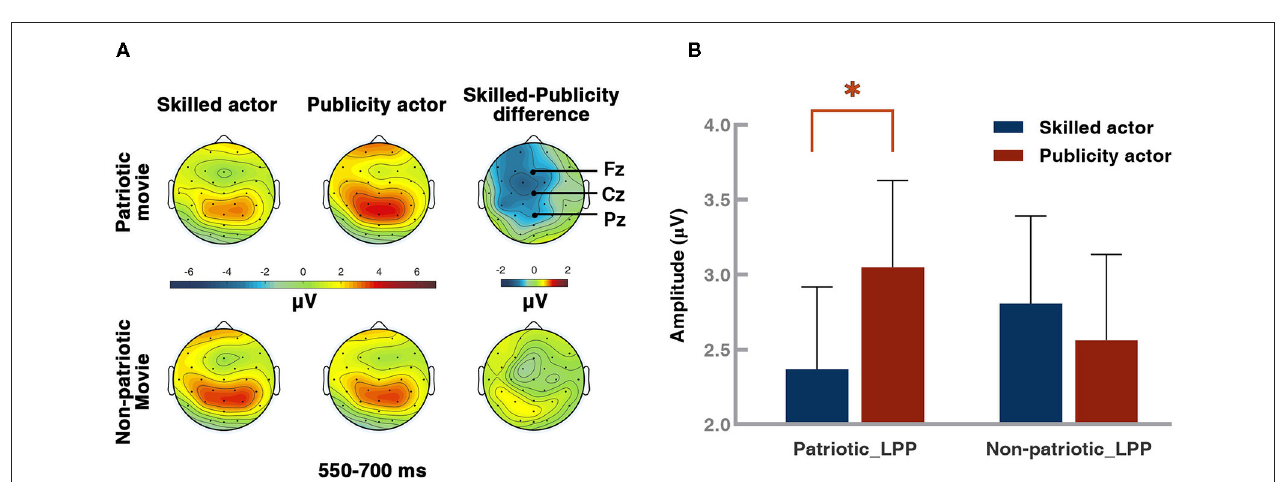
FIGURE 4 | Topography of grand-averaged late positive potential (LPP) waveforms from Pz and LPP results. (A) Topography of LPP. (B) LPP-averaged amplitudes of patriotic movies and non-patriotic movies starring different types of actors from selected electrodes. The topography was the averaged potential of the 550–700ms time window. Blue represents the skilled actors, and red represents the publicity actors. Error bar: standard error, * p < 0.05.